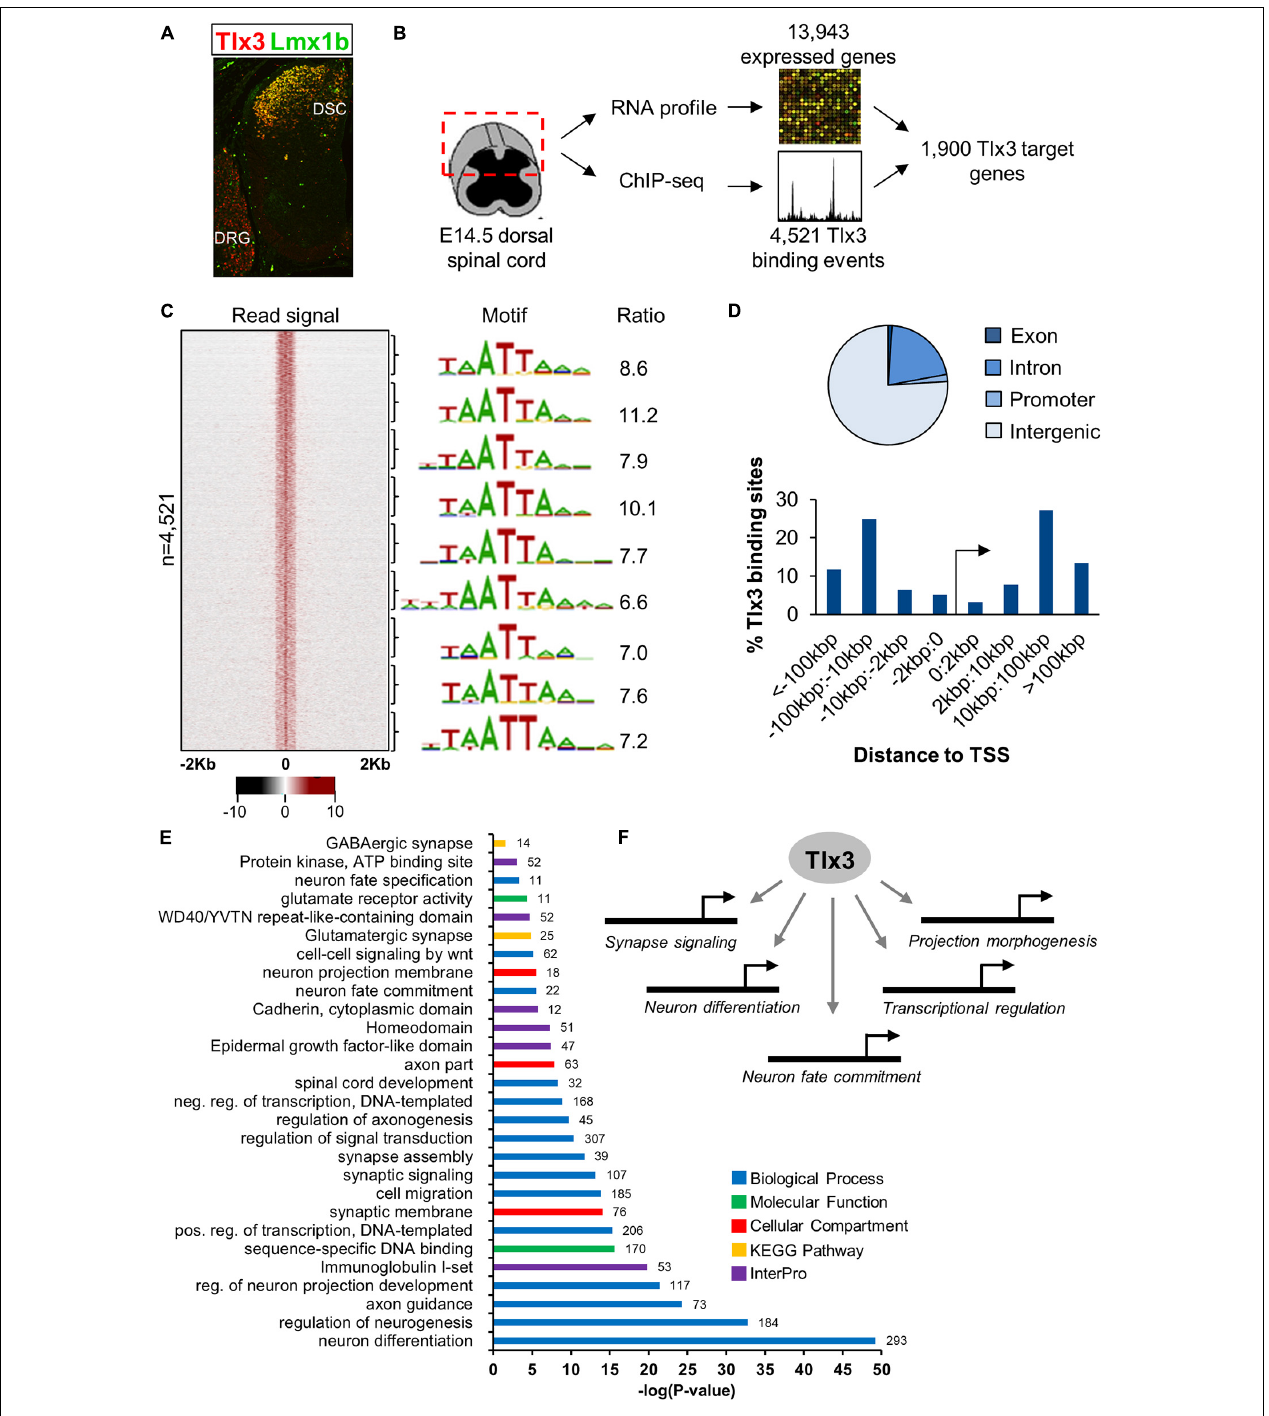
FIGURE 1 | Characterization of Tlx3 transcriptional program in embryonic dorsal spinal cord. (A) Immunofluorescence analysis of Tlx3 and Lmx1b in E14.5 mouse spinal cord. Expression of Tlx3 and Lmx1b extensively co-localize in dorsal spinal cord, whereas in dorsal root ganglion only Tlx3 is detected. (B) Strategy used to identify direct targets of Tlx3 in dorsal spinal cord. (C) Heat map displays sequencing signal intensity in genomic regions centered at Tlx3 peak summits, ordered top-to-bottom by increasing P -value (left). Highest enriched motif in each bin of 500 bound regions (middle). Enrichment ratio of each motif matches in bound sequences over upstream control sequences (right). (D) Genomic features associated with Tlx3 binding sites (top) and relative association to the nearest TSS (bottom). (E) Biological processes over-represented in the list of Tlx3 putative target genes (i.e., bound and expressed in the dorsal spinal cord) using DAVID GO analysis. Colored bars represent the GO category, KEGG pathway or InterPro protein class and in front of each bar is the number of target genes associated with that term. (F) Summary of the functions controlled by Tlx3 in the dILB neurons specification.